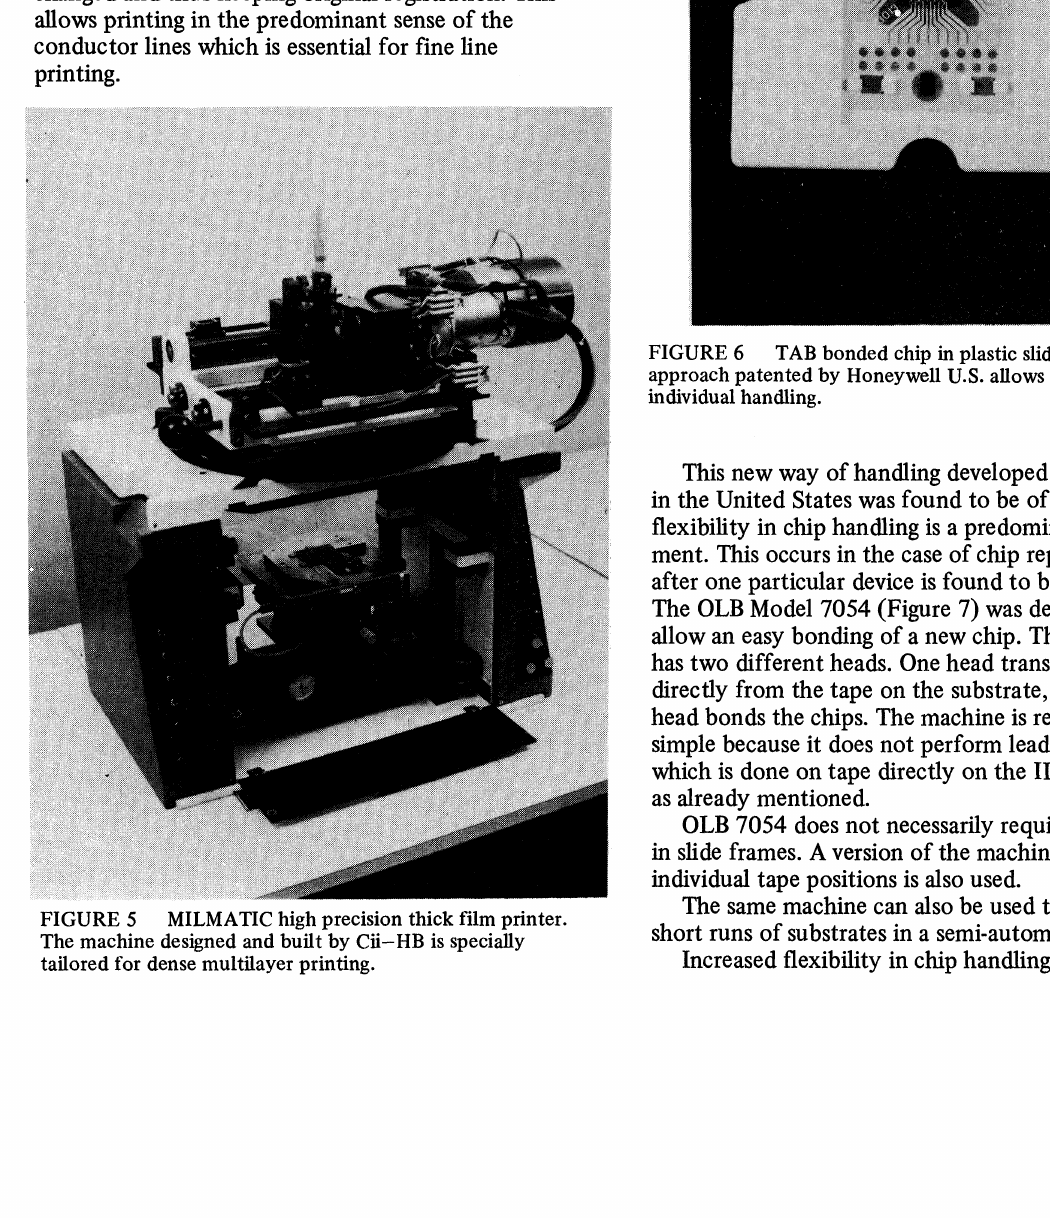
TAB bonded chip in plastic slide carrier. This approach patented by Honeywell U.S. allows possibility of individual handling.